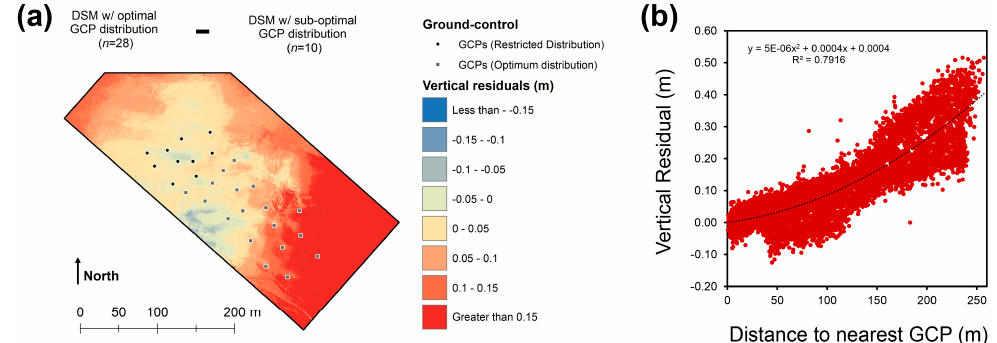
Figure 4. ( a ) The residuals assessed by subtracting a digital surface model (DSM) produced using a uniform distribution of ground control points (GCPs) from a DSM produced using a sub-optimum clustered GCP distribution. Error increases into the decimetre range with distance from the GCP cluster. ( b ) Polynomial regression of sampled cells (a total of 10,000 values) from the DSM of difference highlighting the influence of GCP distribution on error.